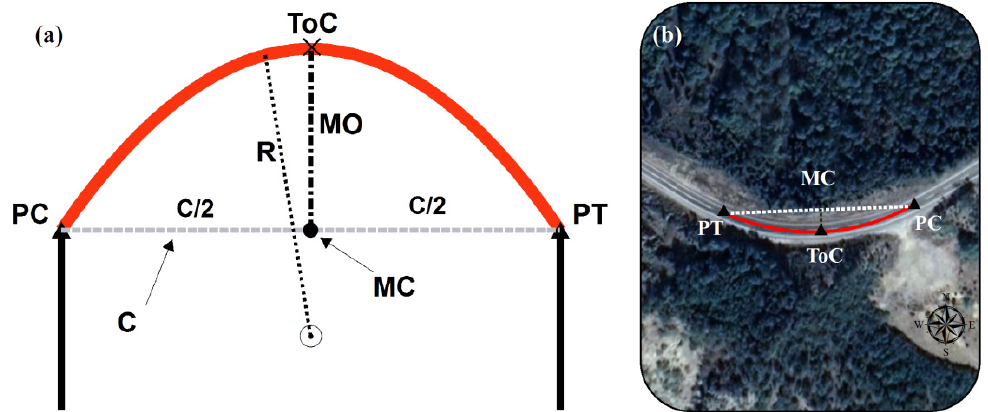
Figure 3. The geometric structure and elements of a horizontal curve ( a ) and the position of the curve on the satellite image ( b ).